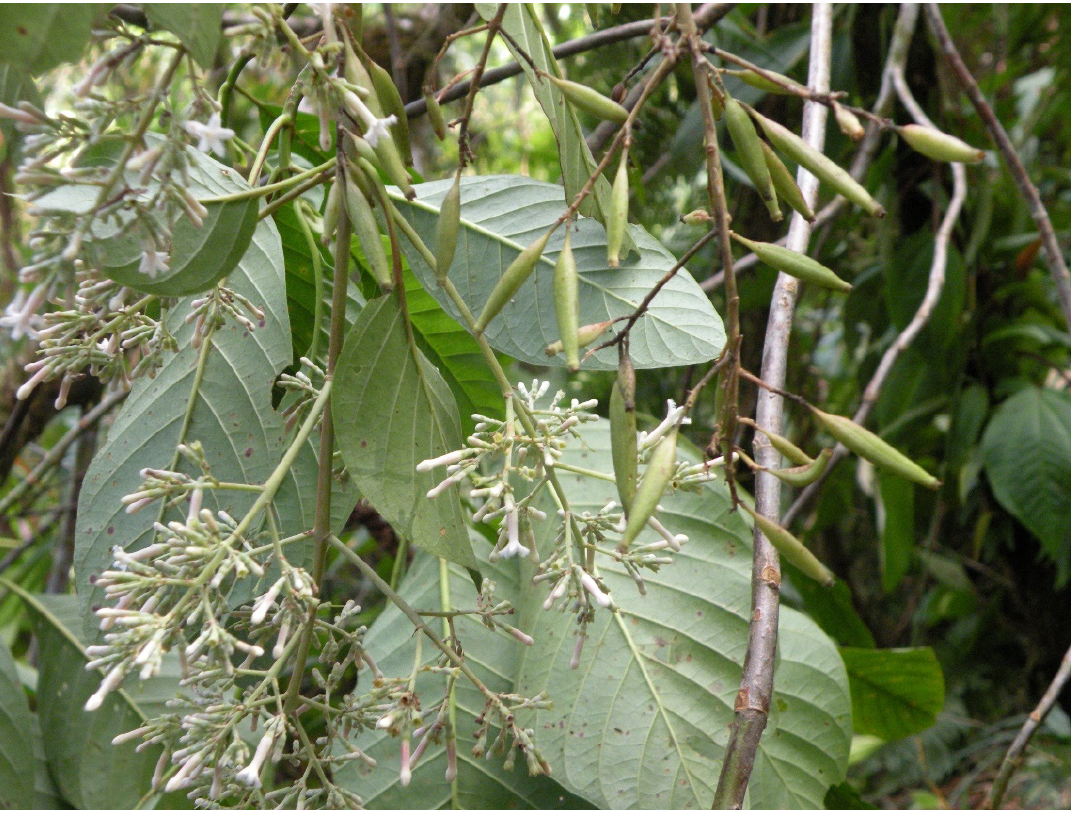
Figure 8. Cinchona micrantha Ruiz & Pav. growing in a thermotropical ultra − hyperhumid Amazonian forest from southern Peru (San Gabán, Puno. Photograph by E.L.P.). Tafalla and Manzanilla also collected Theobroma cacao L. and T. alba Ruiz & Pav. (= T. subincanum Mart.) and the palm Phytelephas macrocarpa in the Amazonian